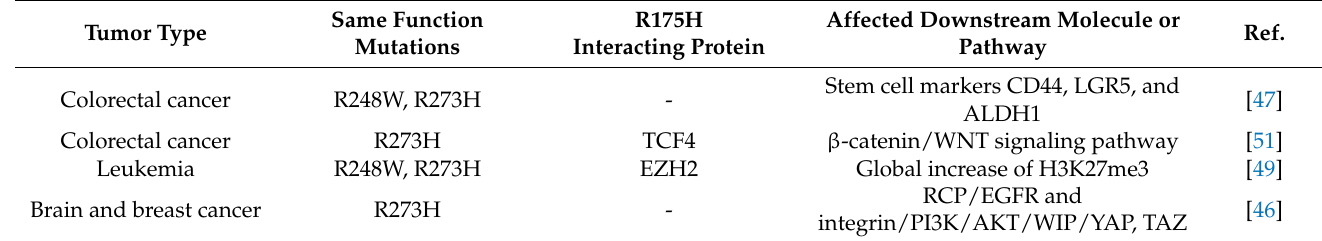
Table 5. Summary of p53-R175H gain-of-function promoting tumor initiation and conferring stemness. Tumor